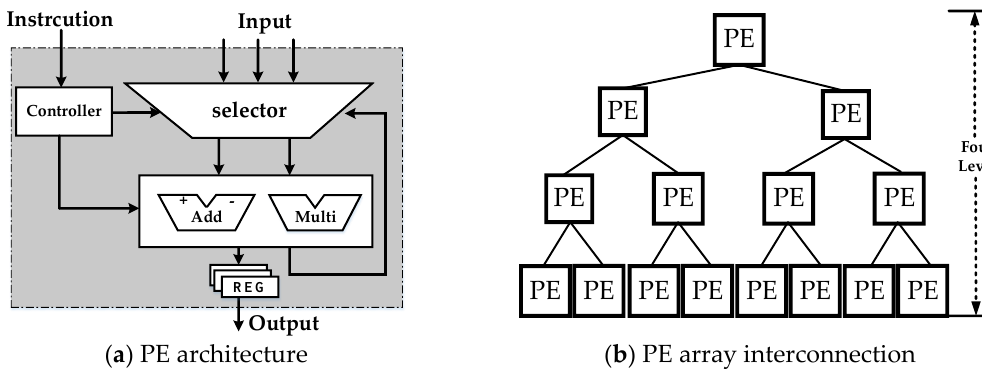
Figure 4. Programmable element (PE) and PE array architecture.